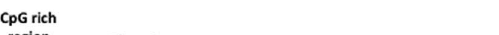
FIGURE 1 |A Schematic representation of the rhesus monkey GnRH gene depicting the location of the 5’ CpG island (CGI) and nucleotide sequence of this region .This region is the only classifiable CGI within 2500 bases upstream of the GnRH gene transcription start site. CpG sites are indicated with numbers corresponding to the CpG sites in Figures 2 and 3 .